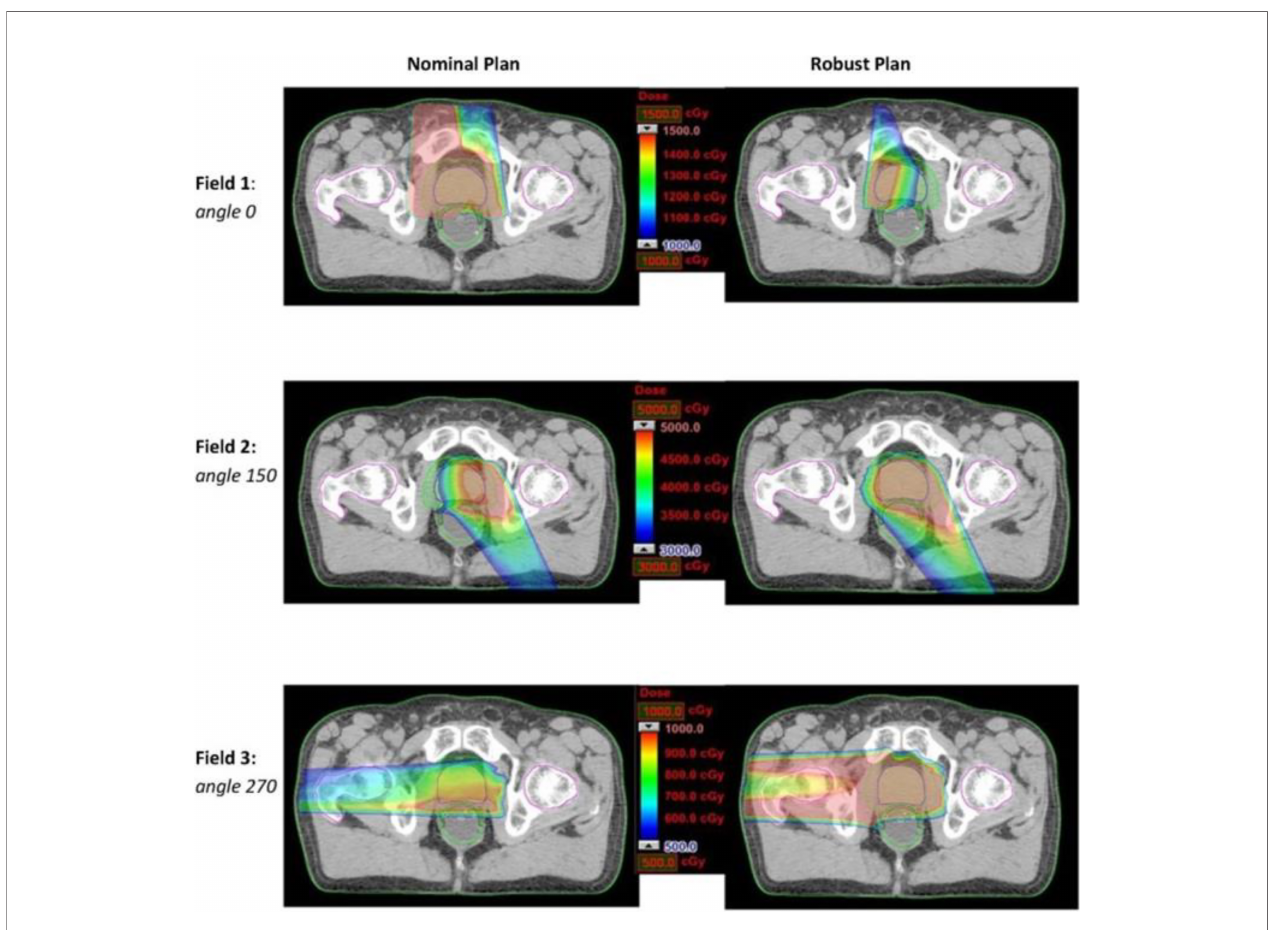
FIGURE 9 | Dose distributions for each beam angle in the transverse plan for comparing the nominal plan and worse-case robust plan of three-beam IMPT plan for one prostate cancer patient (69) (Open